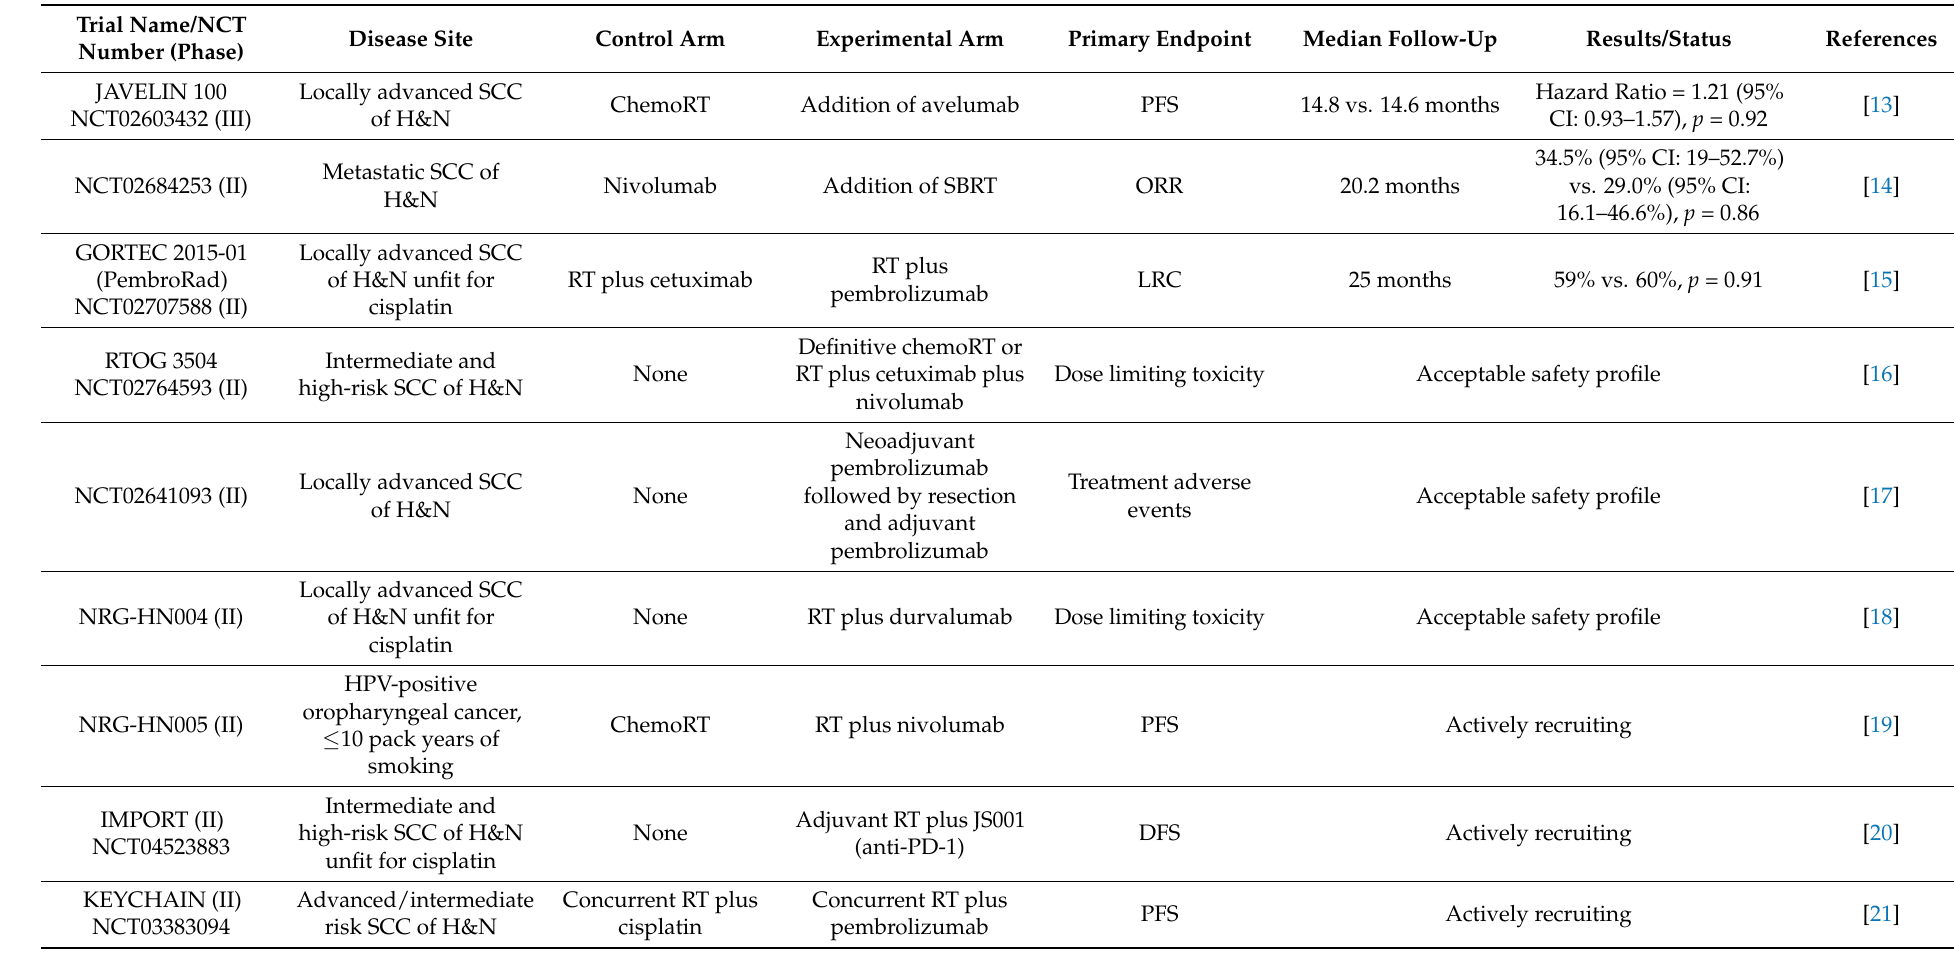
Table 1. Recent and ongoing phase II-III studies evaluating RT with immunotherapy in head and neck